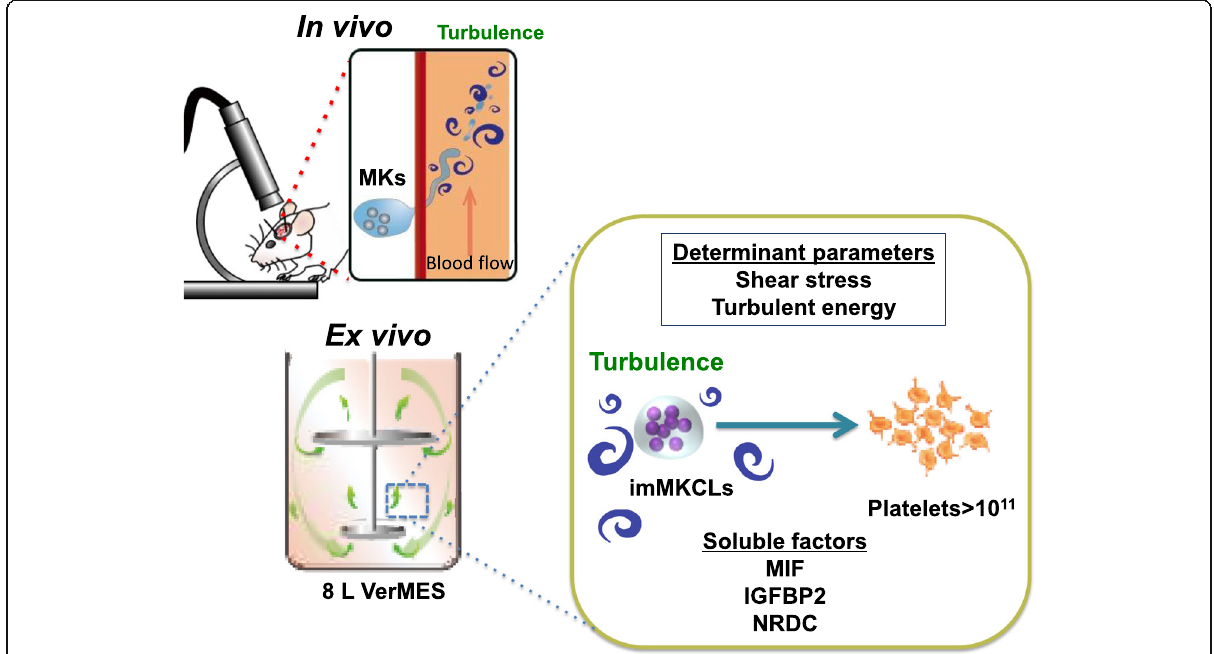
Fig. 2 Turbulence promotes platelet generation to allow for the production of 100 billion platelets ex vivo. From in vivo imaging, platelet release was observed at the sites of turbulence in the blood flow. By applying turbulence ex vivo, we succeeded in obtaining 100 million functional platelets from a single imMKCL clone in an 8-L VerMES. Two physical parameters, turbulent energy and shear stress, are involved in the bioreactor scale-up, and turbulence stimulated imMKCL to releases the soluble factors IGFBP2, MIF, and NRDC, which activated the platelet